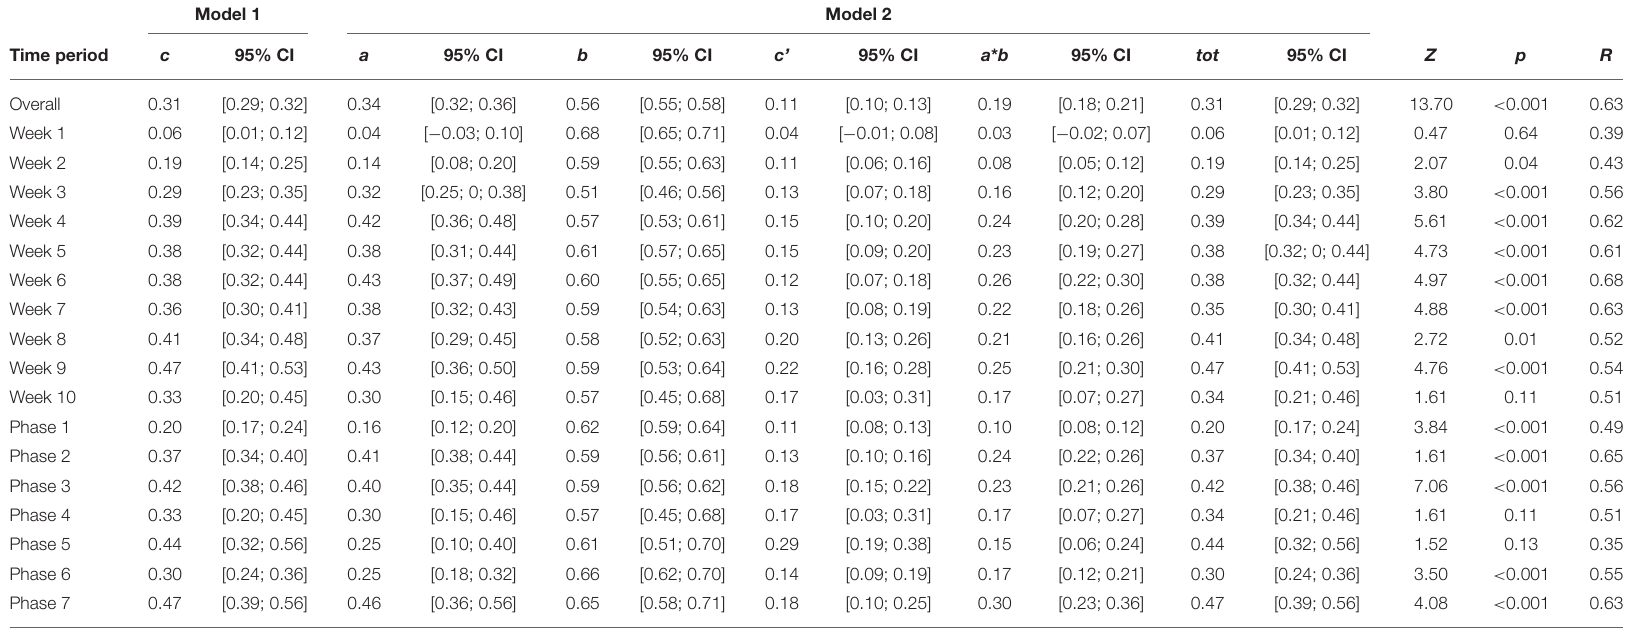
TABLE 1 | Mediation analysis results for Actual self-protective behavior (ASPB) credibility-alertness-behavior (CAB)